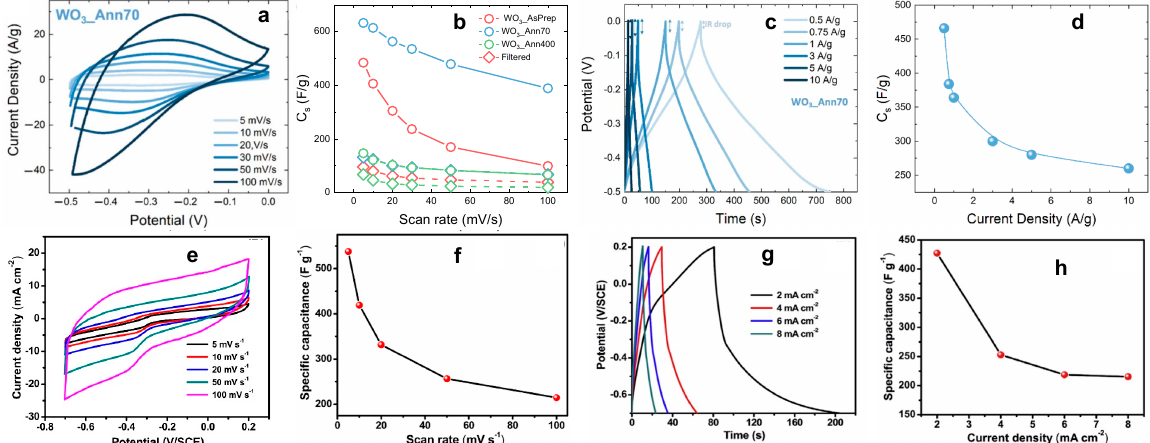
Figure 6. ( a , e ) CV and ( c , g ) GCD curves and the related Cs as a function of ( b , f ) scan rate and ( d , h ) current density, respectively, of ( a – d ) hexagonal WO 3 nanorods and urchin-like nanostructures [19] and ( e – h ) hexagonal WO 3 nanorods [57]. Reproduced with permission.